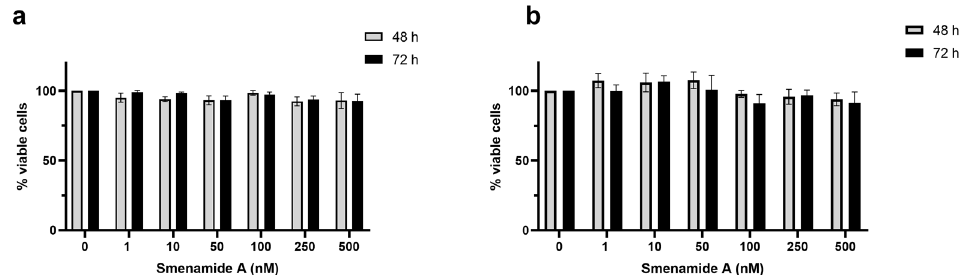
Figure 3. Smenamide A is not cytotoxic in all tested cell lines. Percentage (%) of viable A-431 ( a ) and MCF-7 ( b ) cells after treatment with increasing concentrations of smenamide A for 48 or 72 h.